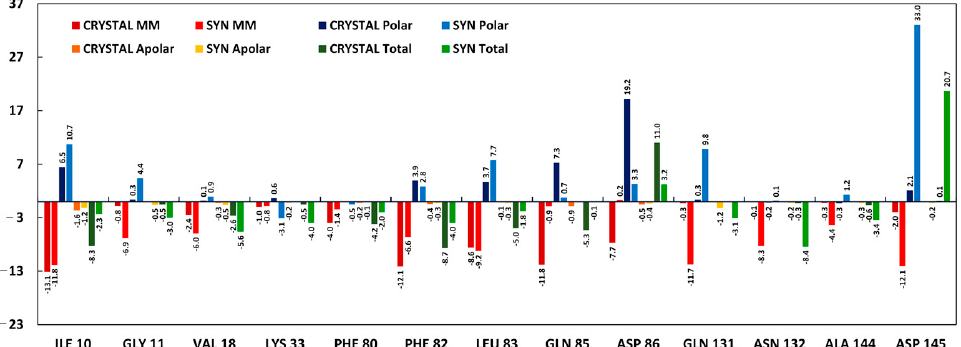
Figure 7. Energetic components’ values of the selected amino acid residues with HI 5 syn -isomer ( Syn ) and co-crystallized ligand (Crystal).